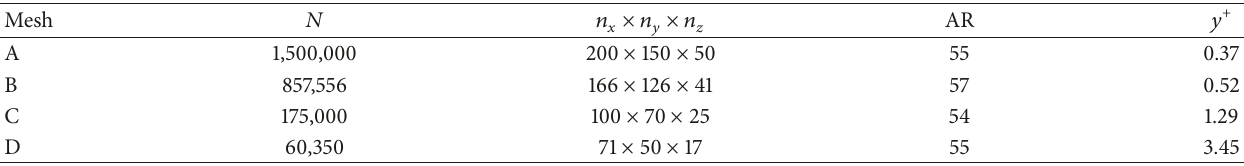
Table 2: Mesh parameters (total number of mesh nodes, number of nodes in streamwise, crosswise and spanwise direction, aspect ratio, and calculated maximal nondimensional wall distance) used for the RANS